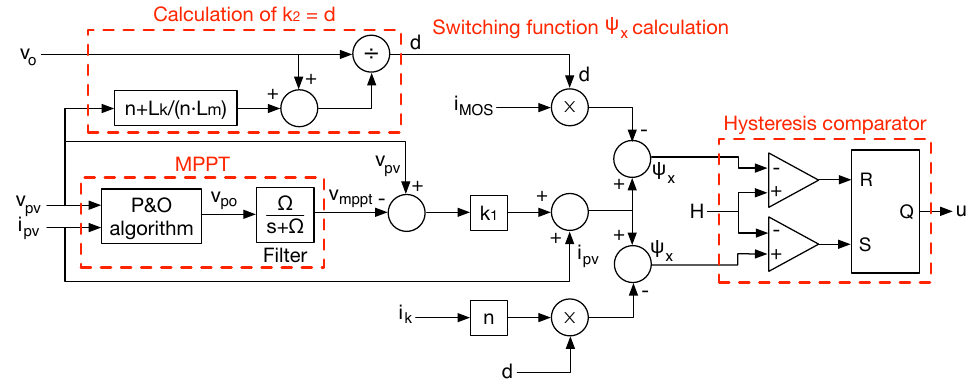
Figure 5. Implementation of the proposed control system.